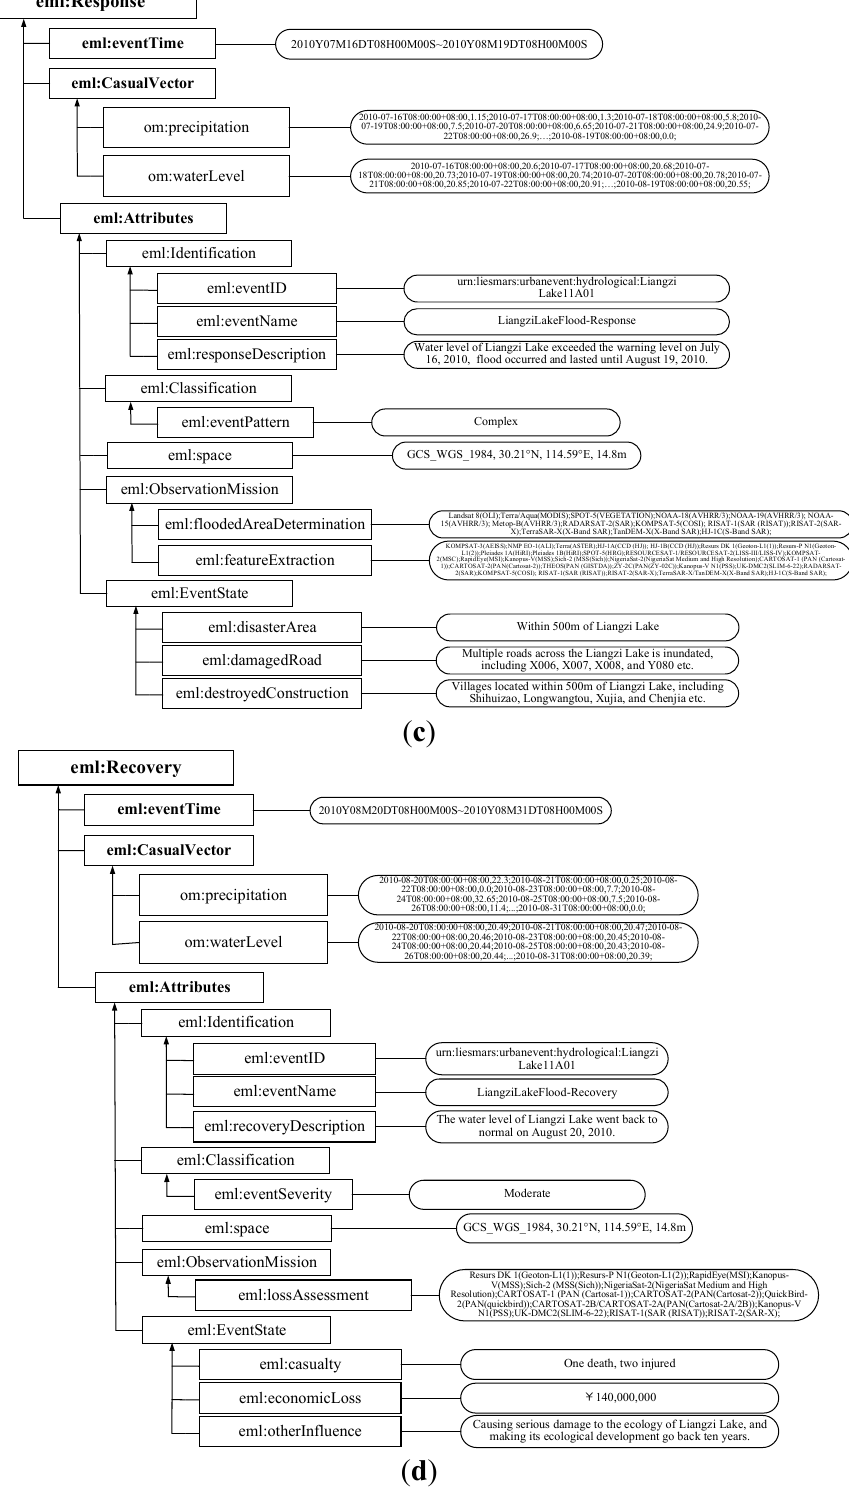
Figure 9. Modeling results of different event phases of the LZ Lake flood in